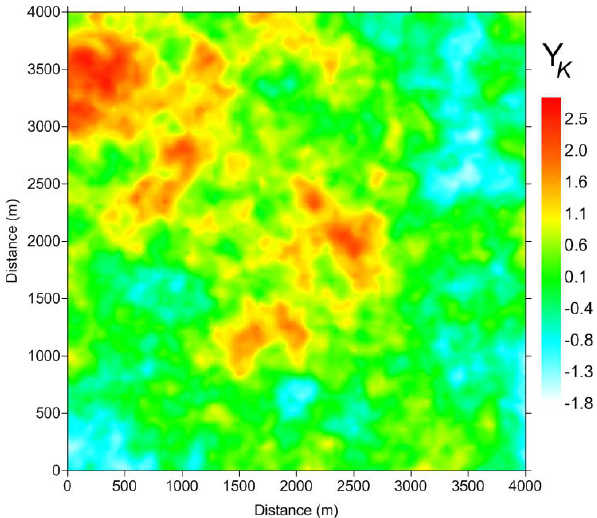
Fig. 13. Reference Y K field with=0.301 log m day − 1 (2.0 m day − 1 ) and=0.500 (log m day − 1 ) 2 .